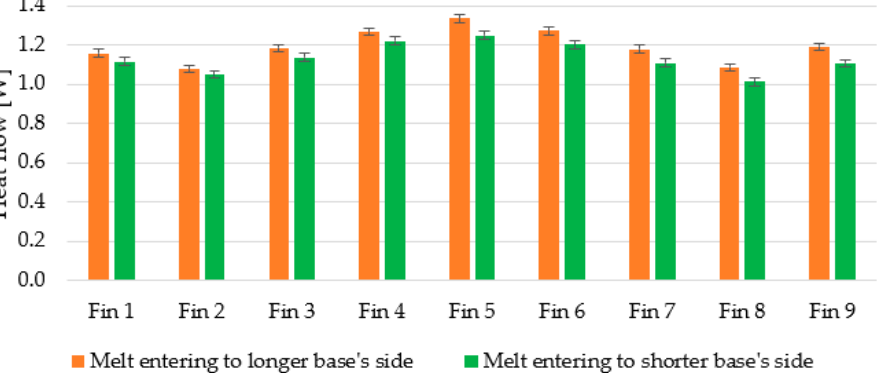
Figure 16. Comparison of individual heat flows leaving fins of heat sinks in the “upside-down” position differing in the melt entry.